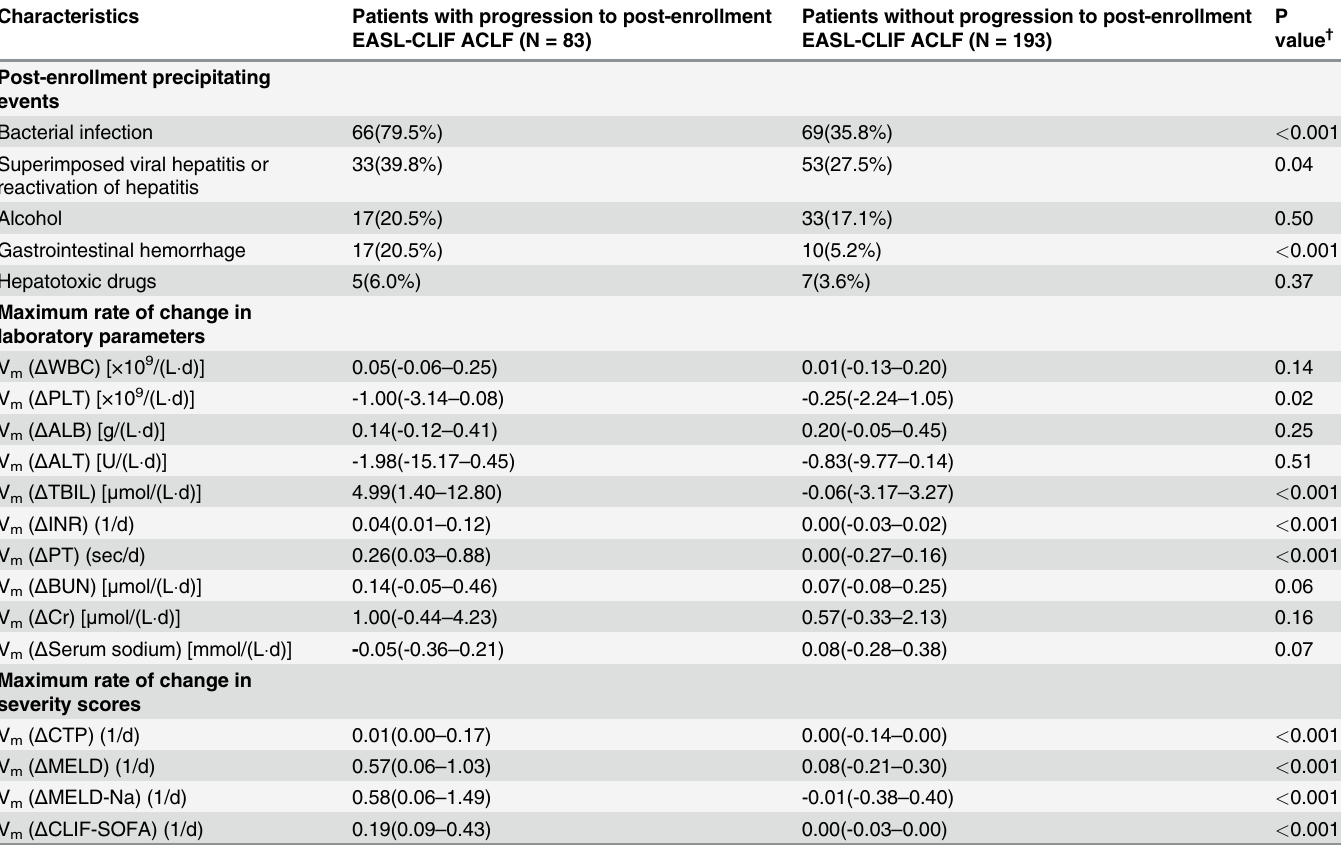
Table 3. Comparison of characteristics after enrollment between patients with and without progression to post-enrollment EASL-CLIF ACLF. Characteristics